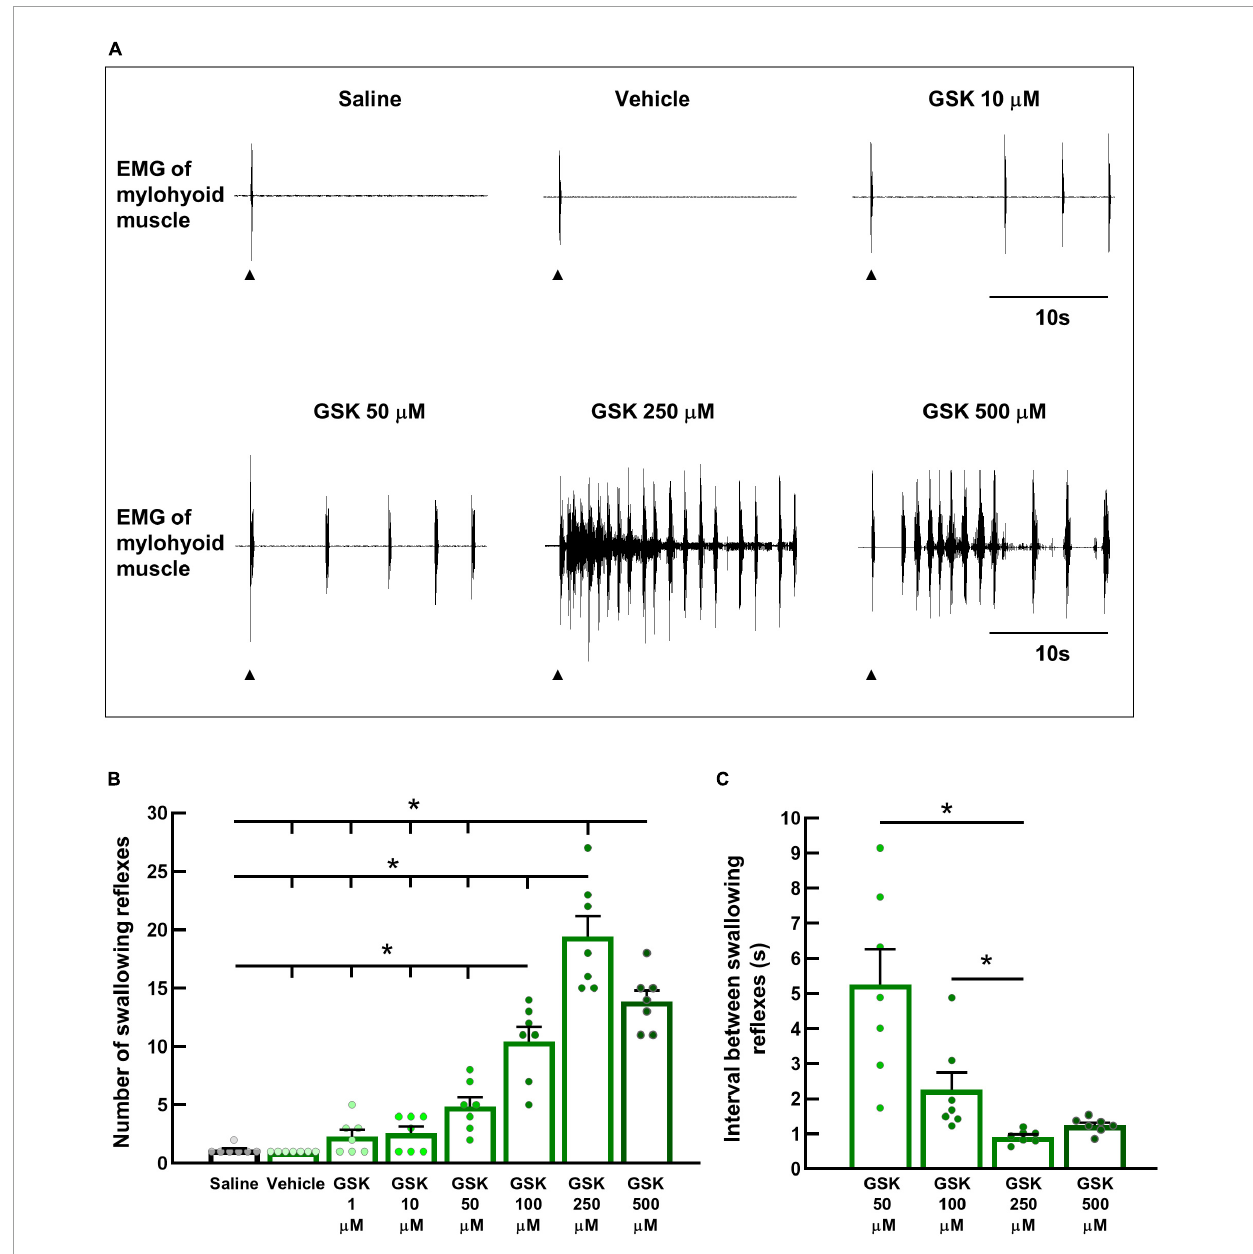
FIGURE4 Topical application of GSK1016790A, a TRPV4 agonist, triggered swallowing reflexes in a dose-dependent manner. (A) Swallowing reflexes triggered by saline, the vehicle for GSK1016790A, and different GSK1016790A concentrations. Black arrowheads indicate the onset of stimulating solution delivery. (B) Comparison of the number of swallowing reflexes triggered by saline, the vehicle for GSK1016790A, and different GSK1016790A concentrations. * P < 0.05 ( F = 57.34) by one-way repeated measures ANOVA followed by Tukey’s test. (C) Comparison of the intervals between the swallowing reflexes triggered by different GSK1016790A concentrations. * P < 0.05 by Friedman repeated measures ANOVA on ranks followed by Tukey’s test. n = 7. The number of triggered swallowing reflexes was counted for 20 s following application of the stimulating solutions, and